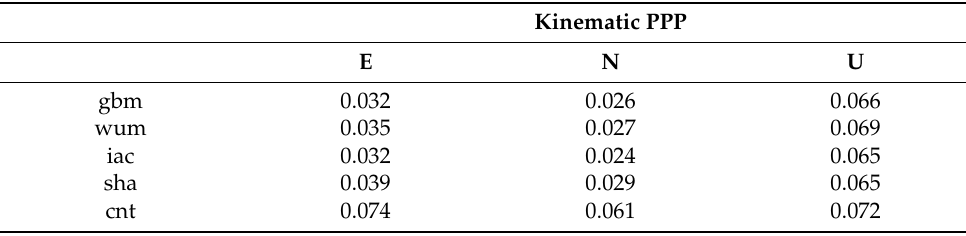
Table 10. The 75th percentile of the positioning accuracy (unit: m) in the ENU directions derived from BDS-3 Kinematic PPP solutions with five precise